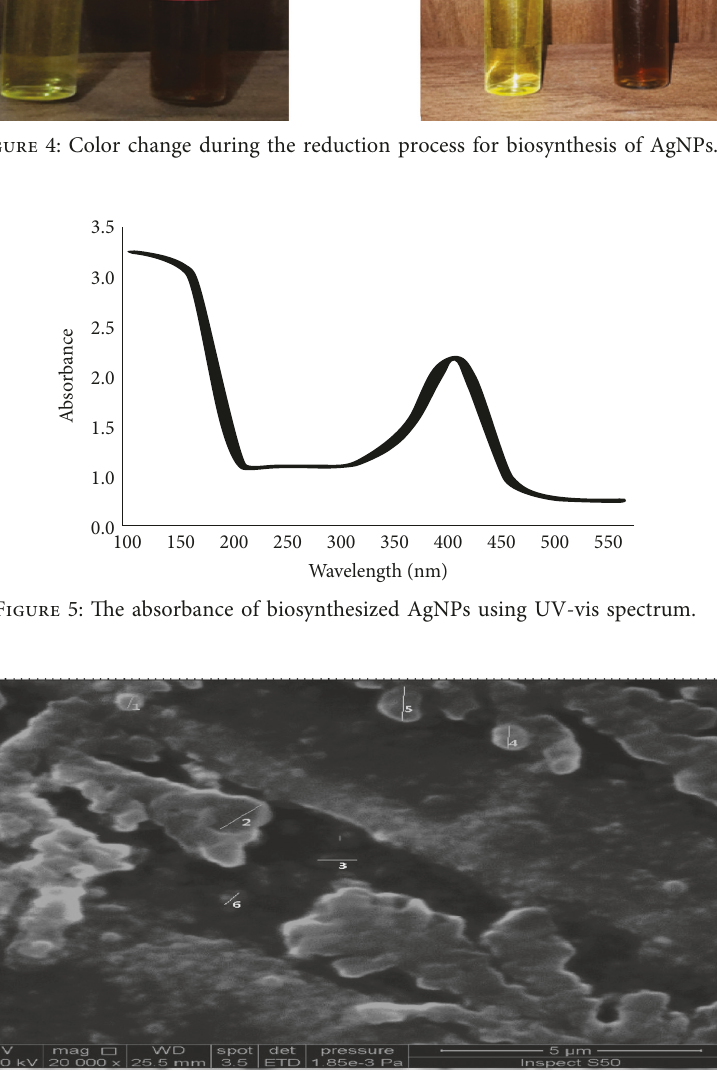
Figure 6: SEM analysis of green-synthesized AgNPs by Malva parviflora leaves